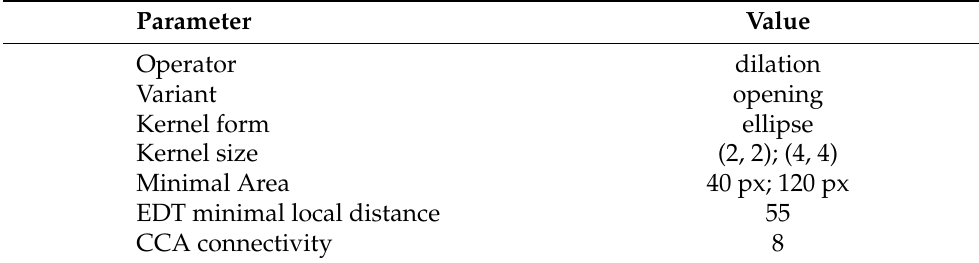
Table 2. CCA workflow